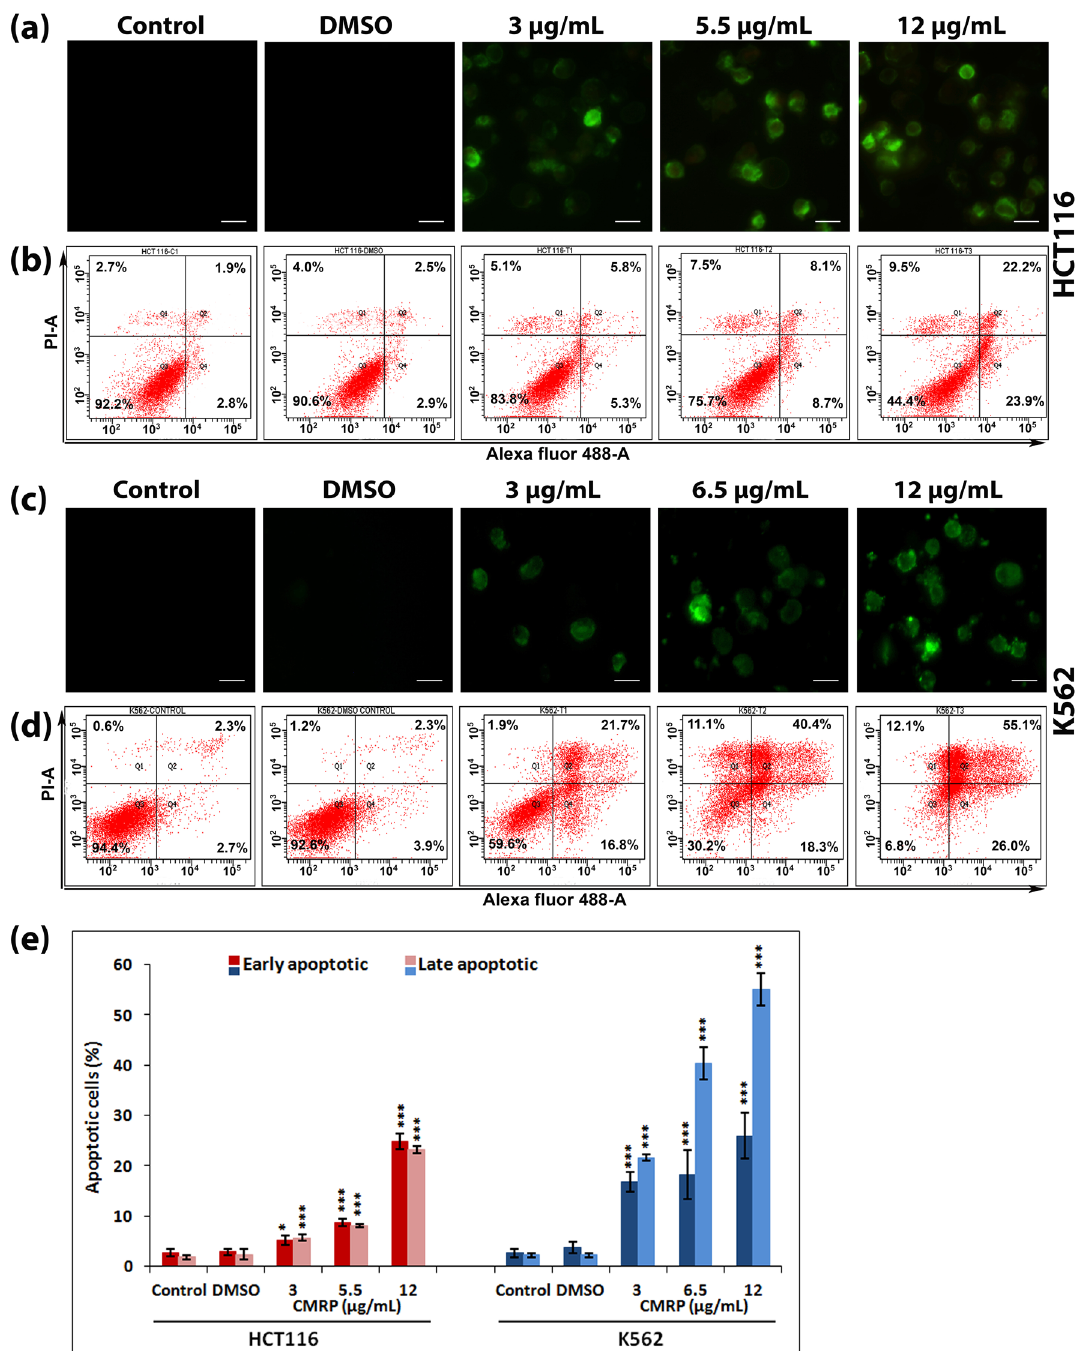
Figure 4. Evaluation of CMRP-induced phosphatidylserine externalization in cancer cells using Alexa Fluor 488-annexin V and PI staining. ( a ) and ( c ) fluorescence microscopy of annexin V stained HCT116 and K562 cells respectively ( b ) and ( d ) flow cytometric evaluation of annexin V and PI stained HCT116 and K562 cells: in each panel the lower left quadrant shows viable cells (negative for both annexin V and PI), lower right quadrant with only annexin V + cells (early apoptotic), upper right quadrant shows annexin V + and PI + cells (late apoptosis) and upper left quadrant shows only PI + cells (necrotic). ( e ) Histogram showing percentages of early and late apoptotic cells. * P < 0.05, *** P <